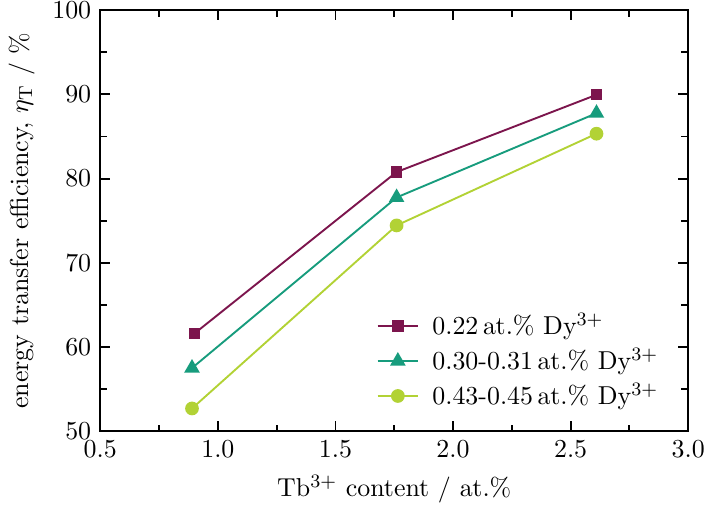
Figure 8. Energy transfer efficiency from Dy 3 + to Tb 3 + ions for varying Dy 3 + contents as a function of the Tb 3 +